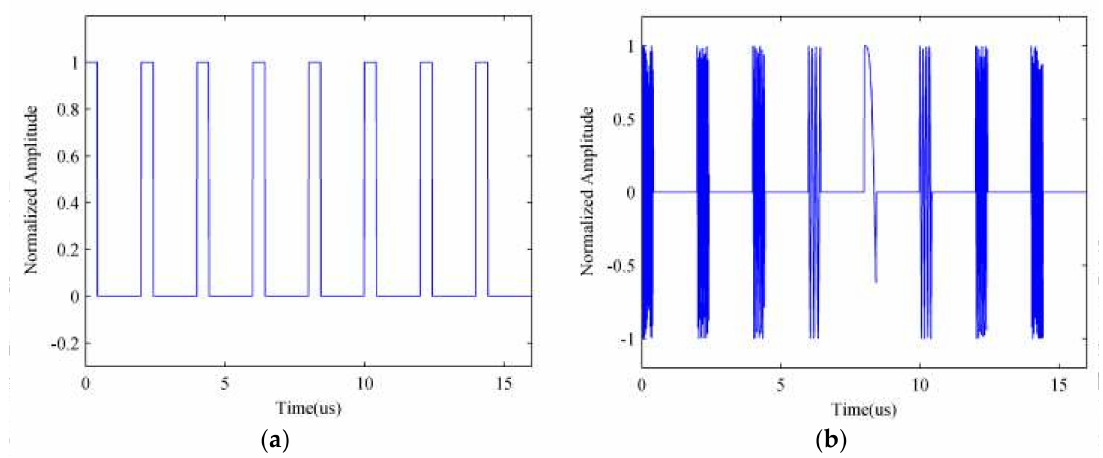
Figure 9. Simulation results of reconstructed signals. ( a ) Rectangular sampling sequence; ( b ) the interrupted sampled radar signal.